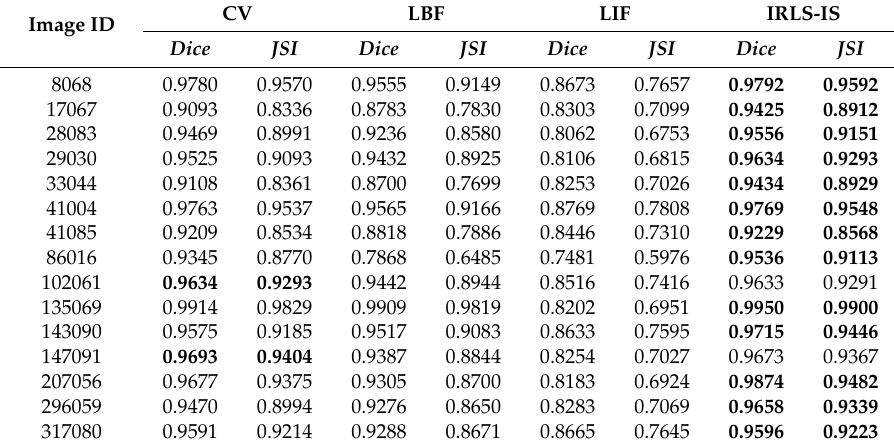
Table 1. The Dice and JSI values of the results of image segmentation on the fifteen Berkeley color images. JSI : Jaccard similarity index; CV: Chan